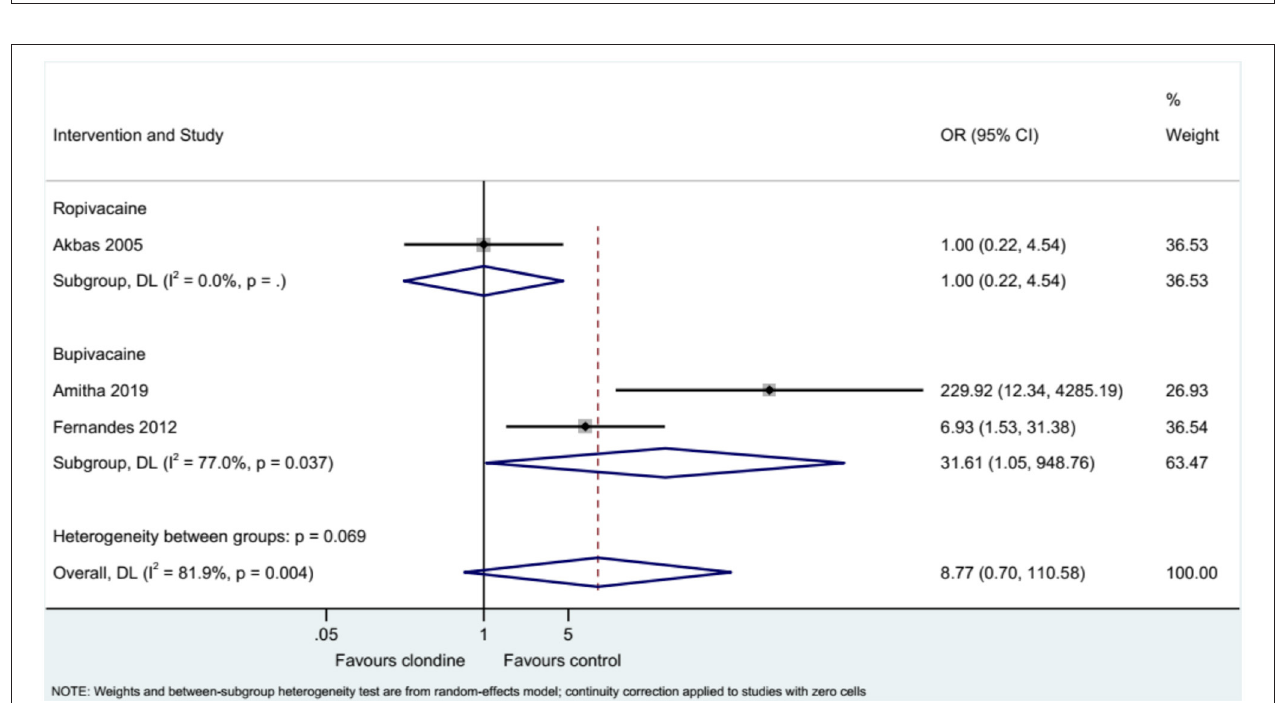
FIGURE 10 | Subgroup analysis of post-requirements by local